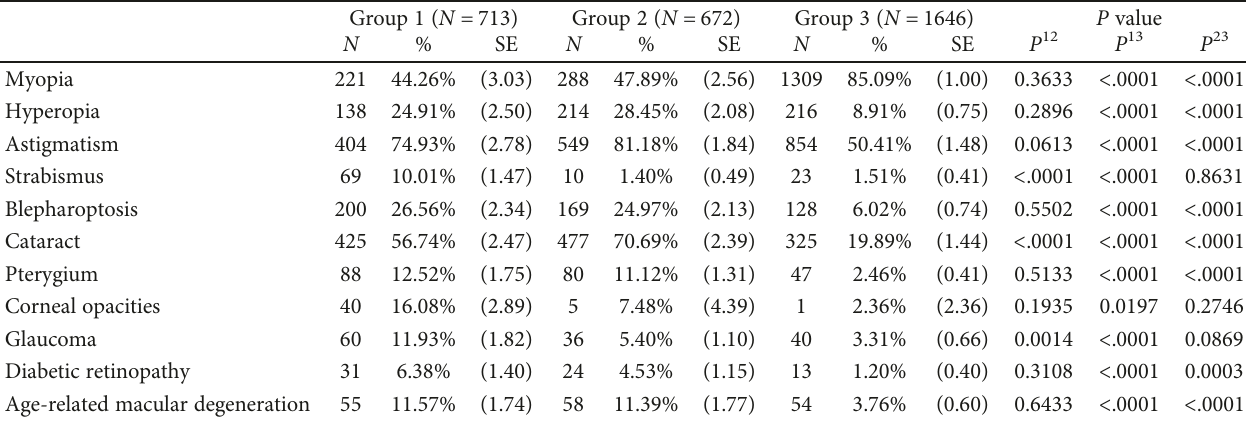
Table 5: Prevalence of ocular comorbidities, according to visual improvement after